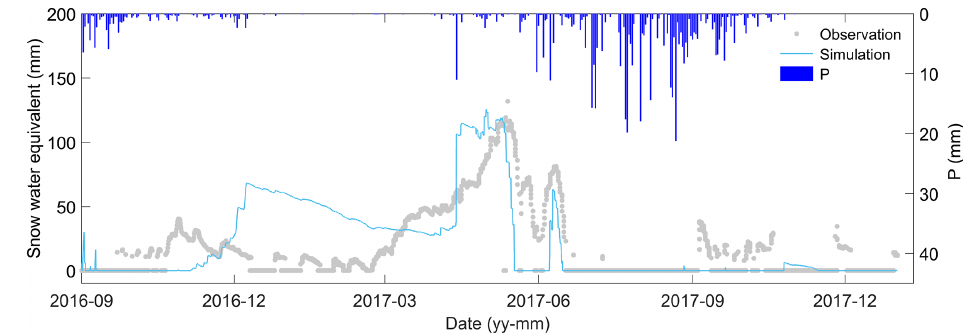
Figure B1. Time series of the observed and estimated snow water equivalent using the developed STEMMUS-UEB model.